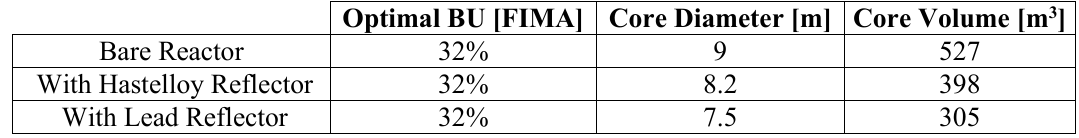
Table III. Finite core criticality: Smallest critical geometry for a cylindrical reactor with and without reflector.